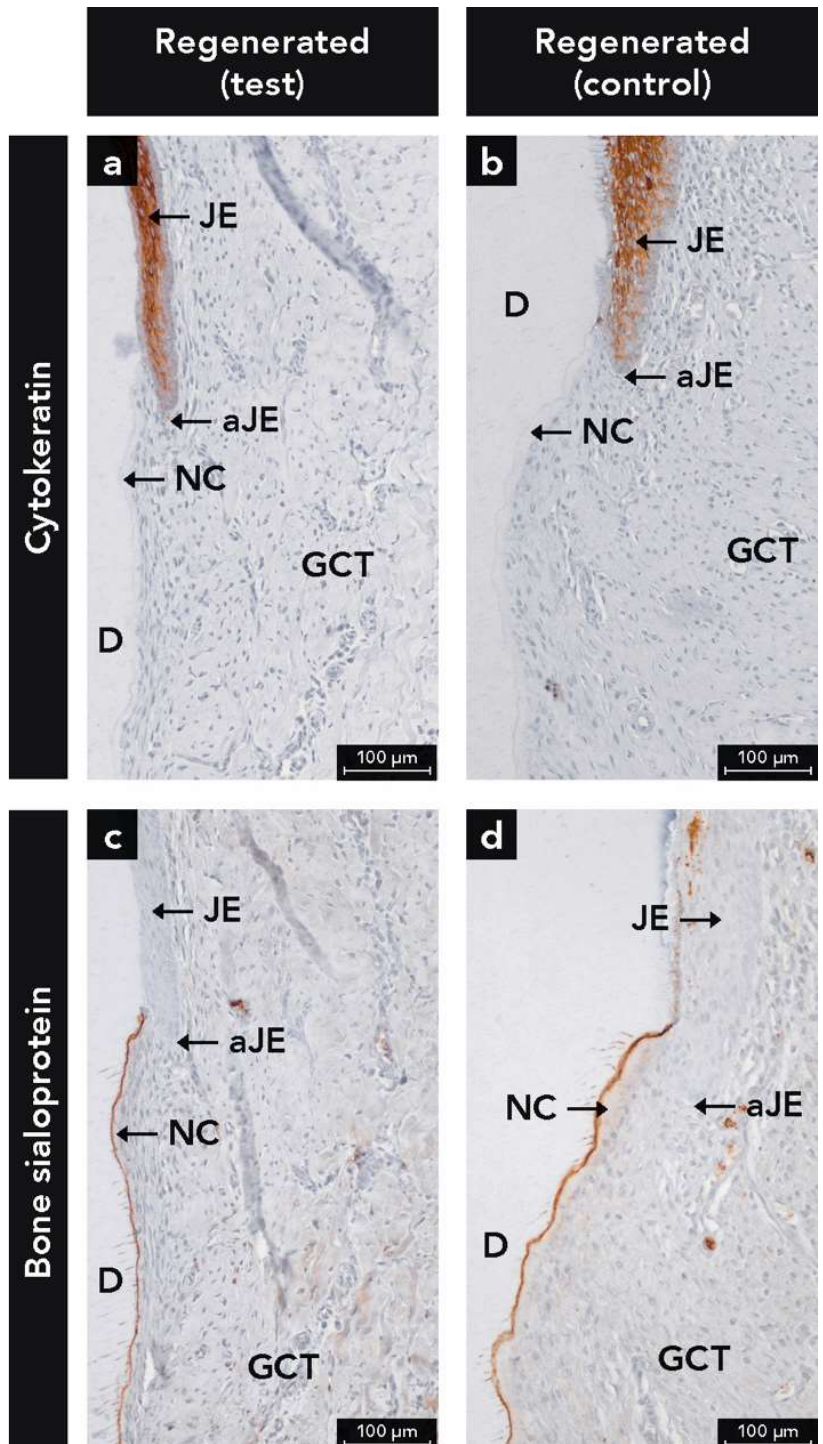
Figure 2. ( a , b ) Micrographs illustrating immunostained epithelial cells of the junctional epithelium (JE) with the use of a pan-cytokeratin antibody; ( c , d ) Micrographs showing immunostained new cementum (NC) with the use of an antibody against bone sialoprotein; Counterstaining: Mayer’s hematoxylin; aJE, apical end of the JE; D, dentin; GCT, gingival connective tissue.